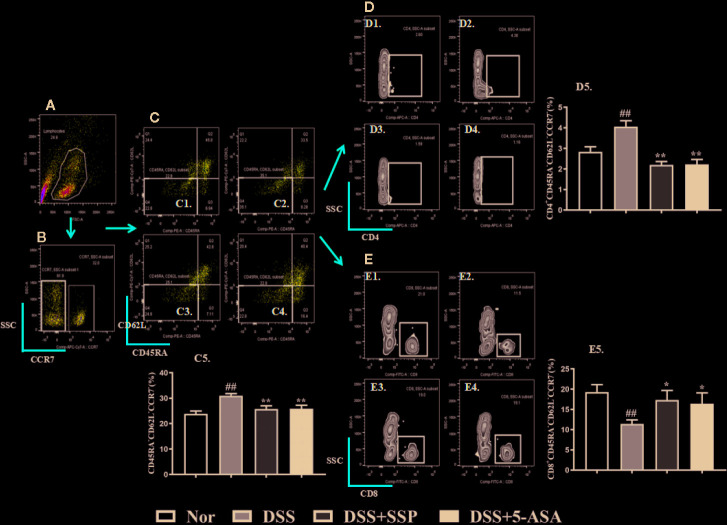
SSP regulated Tem cells in colitis mice. (A) Total lymphocytes in peripheral blood. (B) CCR7− lymphocytes measured by flow cytometry. (C) Double-negative CD45R and CD62L lymphocytes. Cells in the lower left side are Tem cells. C1: Tem cells in normal group; C2: Tem cells in DSS group; C3: Tem cells in DSS + SSP group; C4: Tem cells in DSS + 5-ASA group; C5: statistical analysis of Tem cells in the four groups. (D) CD4+ Tem cell distribution analyzed by flow cytometry. D1: CD4+ Tem cells in normal group; D2: CD4+ Tem cells in DSS group; D3: CD4+ Tem cells in DSS + SSP group; D4>: CD4+ Tem cells in DSS + 5-ASA group; D5: statistical analysis of CD4+ Tem cells in the four groups. (E) CD8+ Tem cell distribution analyzed by flow cytometry. E1: CD8+ Tem cells in normal group; E2: CD8+ Tem cells in DSS group; E3: CD8+ Tem cells in DSS + SSP group; E4: CD8+ Tem cells in DSS + 5-ASA group; E5: statistical analysis of CD8+ Tem cells in the four groups. Data are presented as mean ± SEM (n = 10). ##p < 0.01 versus normal group; *p < 0.05 and **p < 0.01 versus DSS group.